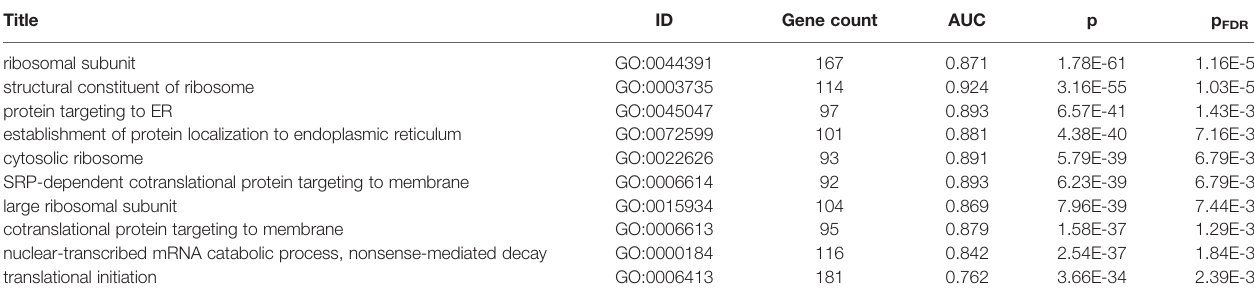
TABLE 1 | Top GO groups enriched for high arginine + lysine proportion.